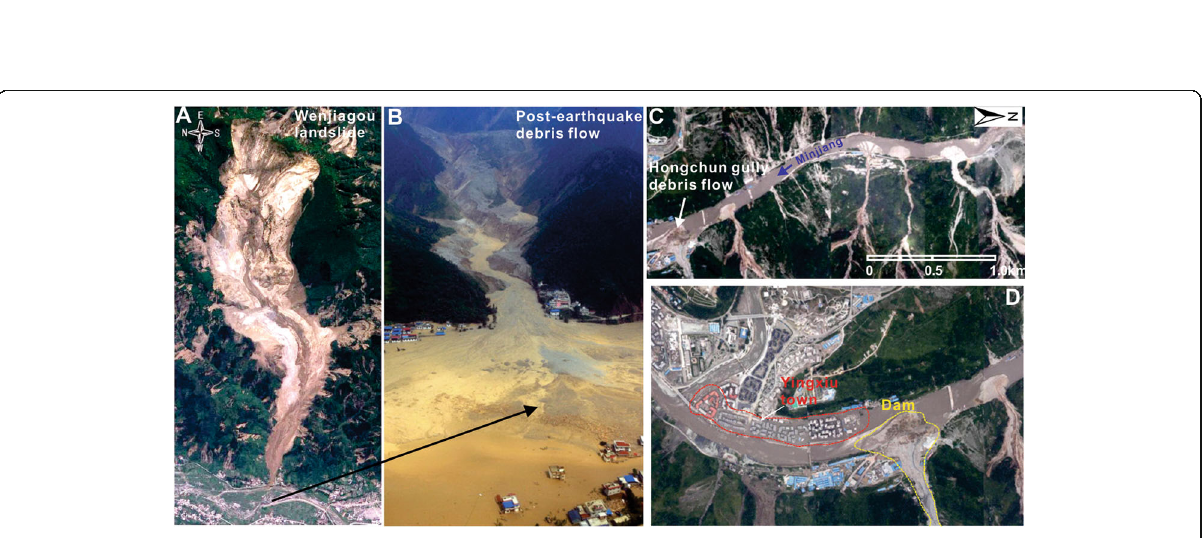
Fig. 12 Post-earthquake debris flow damming events. a Aerial photo of the coseismic Wenjiagou landslide taken on May 18, 2008; b The Qingping debris flow reactivated by heavy rainfall on 12 to 14 August 2010, dammed the Mianyuan river; c Aerial photo of the debris flows along the Minjiang river taken on August 15, 2010; d Hongchun gully debris flow partially dammed the Minjiang river, causing the flooding of the newly constructed Yingxiu